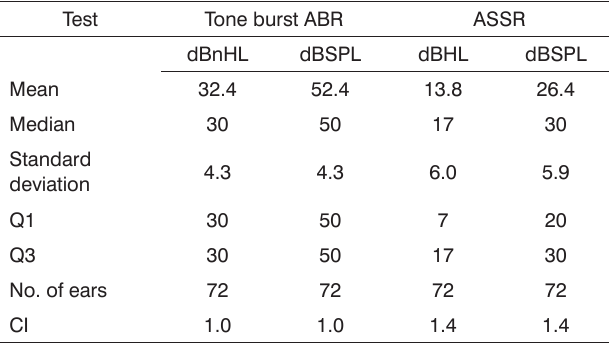
Table 1. Descriptive measures of minimum electrophysiologic responses measure with tone burst ABR (in dBnHL and dBSPL) and ASSR (in dBHL and